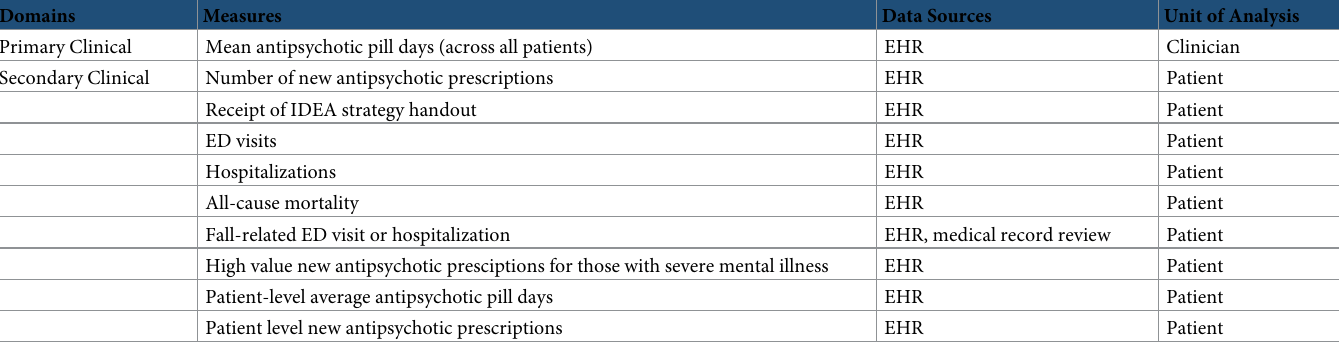
Table 3. Study outcome